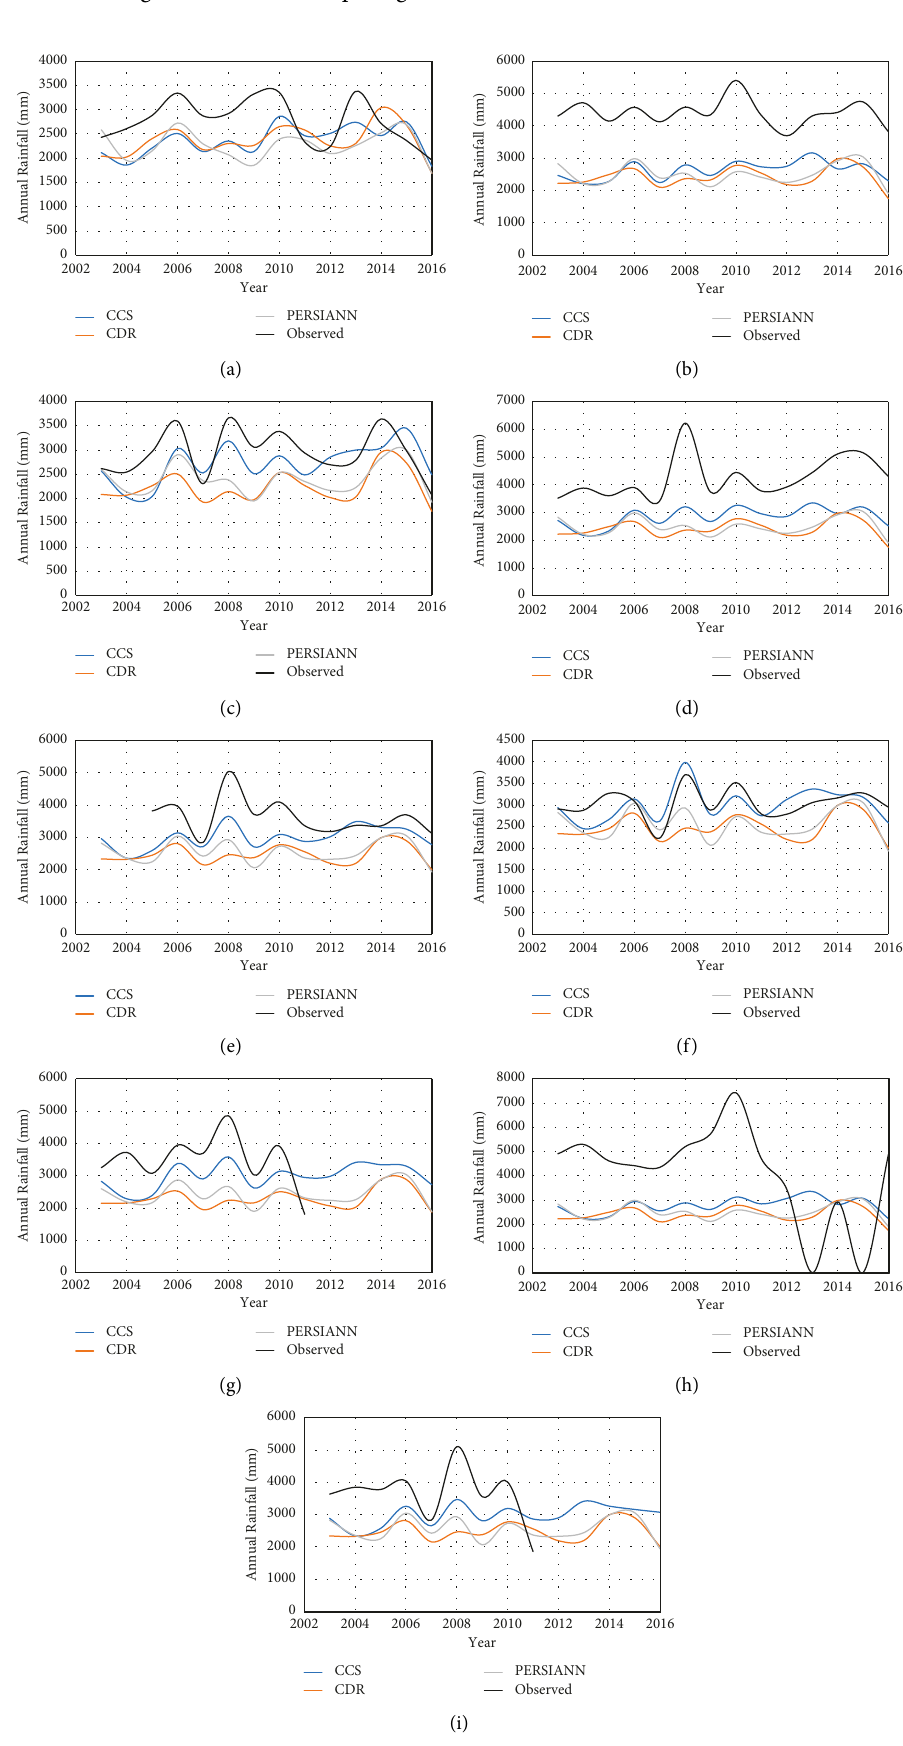
Figure 4: Annual rainfall variations from 2003 to 2016. (a) For Norwood. (b) For Kitulgala. (c) For Holombuwa. (d) For Deraniyagala. (e) For Glenn course. (f) For Hanwella. (g) For Chesterford. (h) For Maliboda. (i) For